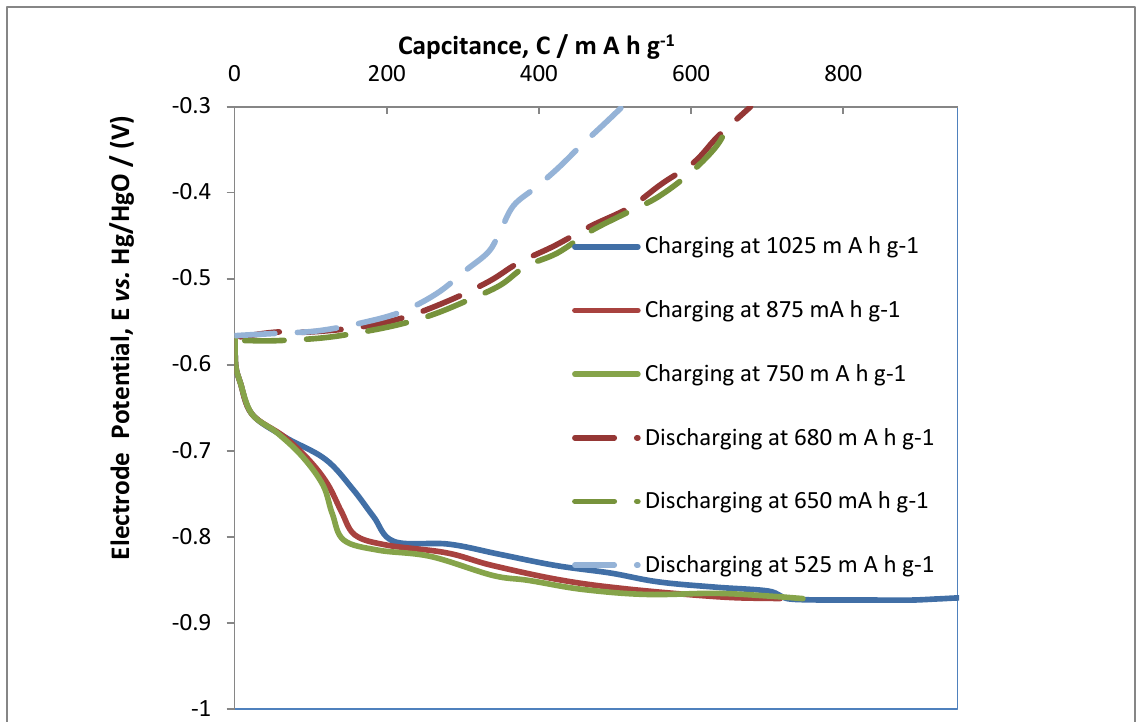
Figure 3. Cycling of MAB at capacities of 750, 875 and 1025 mA h g − 1 with discharging at 680, 650 and 525 mA h g − 1 at ambient conditions in alkaline media having 7 mol dm − 3 NaOH as an electrolyte.